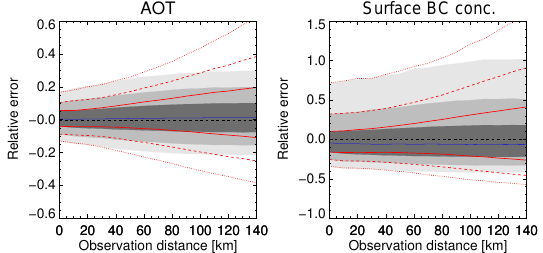
Figure 19. Relative spatial sampling error (monthly data) in case of linear interpolation of model values to the observation, as a function of distance to the grid point. The red lines indicate the errors without interpolation (see also Fig. 14). Results from WRF-Chem MADE over W. Europe. Further explanation in Sect.